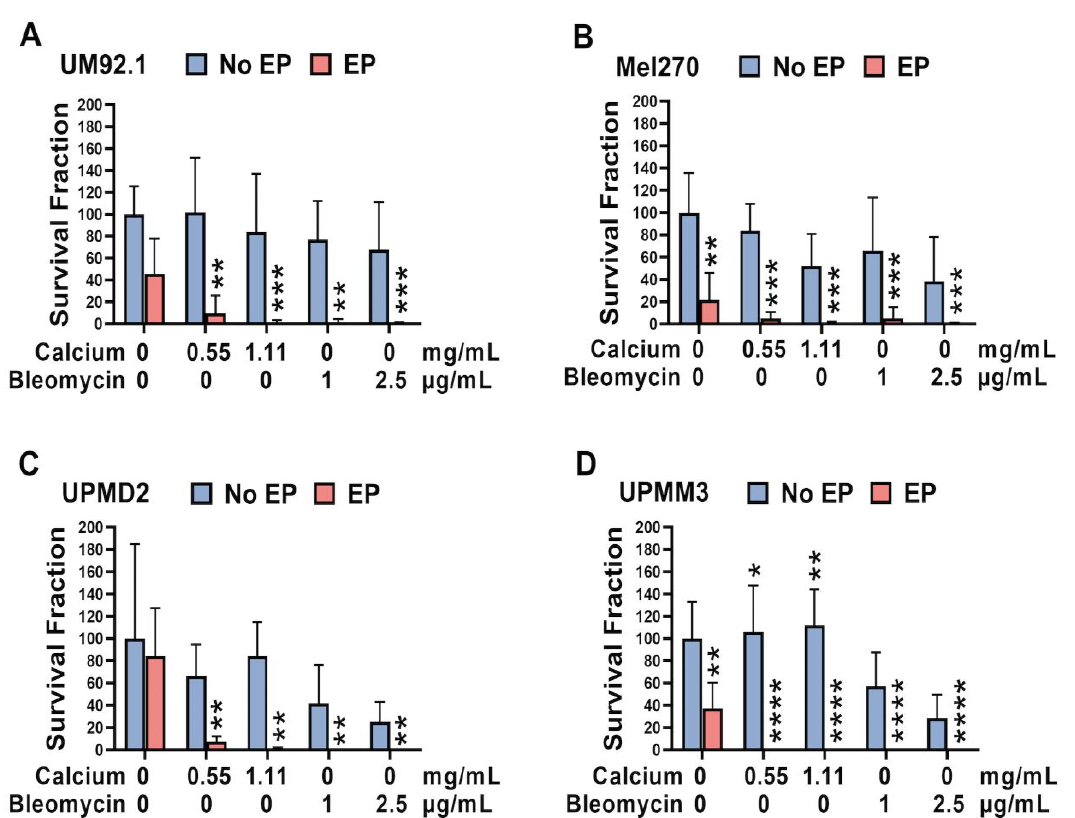
Figure 6. Survival fraction of UM and UPM cells following CaEP and ECT. To investigate the effect of CaEP and ECT on the cell growth of 2D UM and UPM cell cultures, the fraction of seeded cells that retained colony formation capacity was calculated two weeks after treatment ( n = 3 – 6 each con- dition). Therefore, ( A ) UM92.1, ( B ) Mel270, ( C ) UPMD2, and ( D ) UPMM3 cell suspensions were treated with calcium chloride (0.11, 0.28, 0.55, or 1.11 mg/mL) or bleomycin (1 or 2.5 μg/mL) and Untreated cells, calcium chloride alone, bleomycin alone (no EP group), or EP alone constitute the